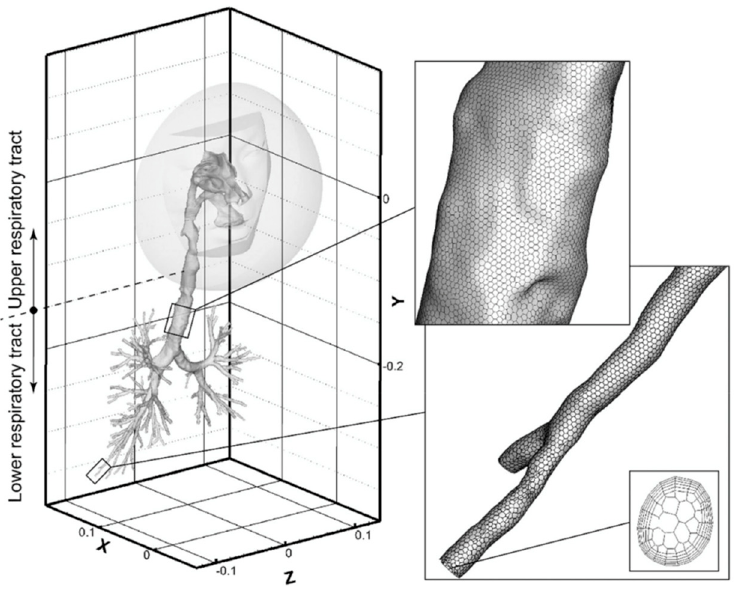
Figure 3. Human lung airway model from Shang et al. (2019). Reprinted with permission from [2]. Copyright 2019, Elsevier.